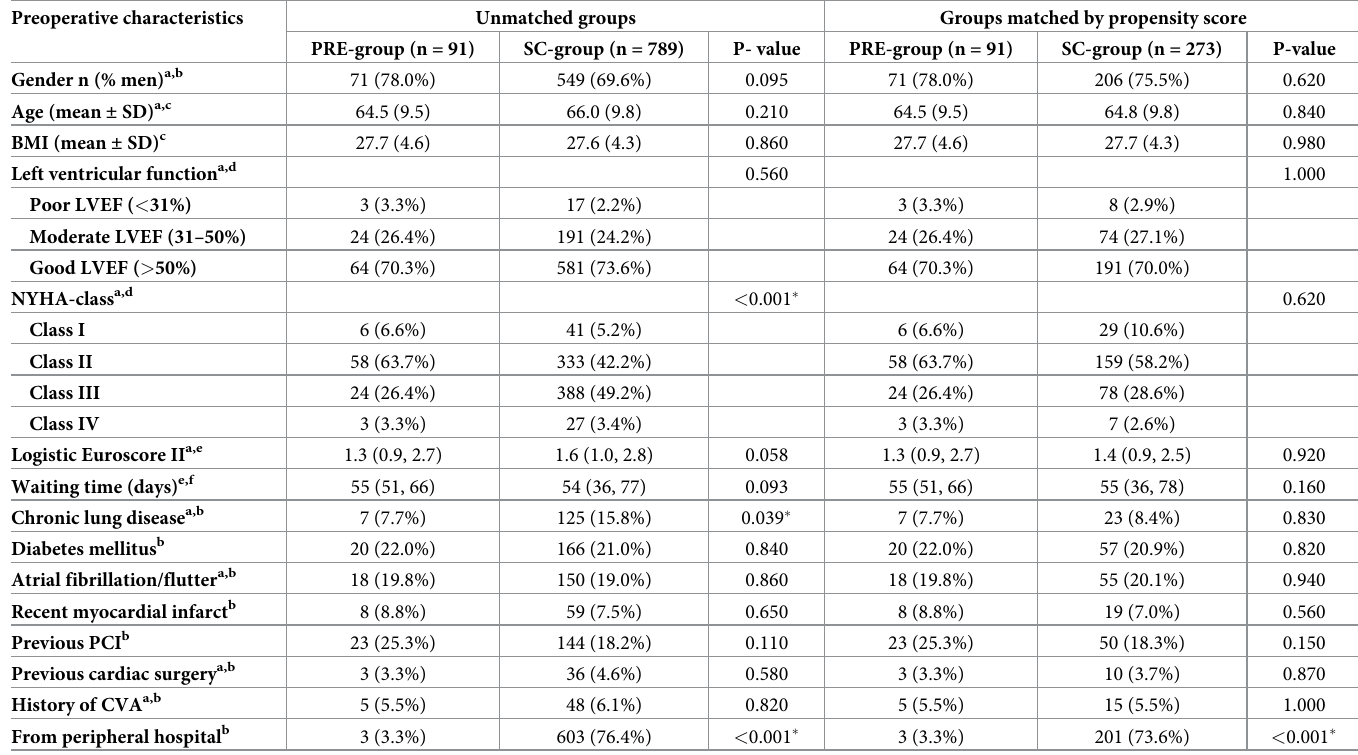
Table 2. Preoperative patient